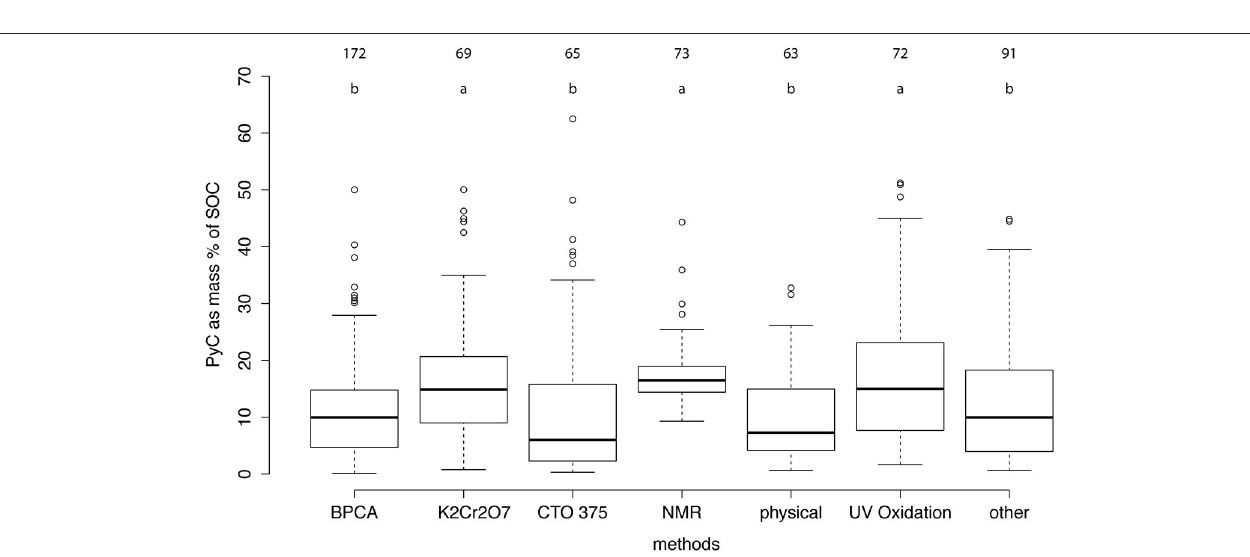
FIGURE 1 | Frequency histogram of PyC content as mass % of the total SOC for the entire database ( n = 569). Each column represents an increment of 2% of the PyC content.